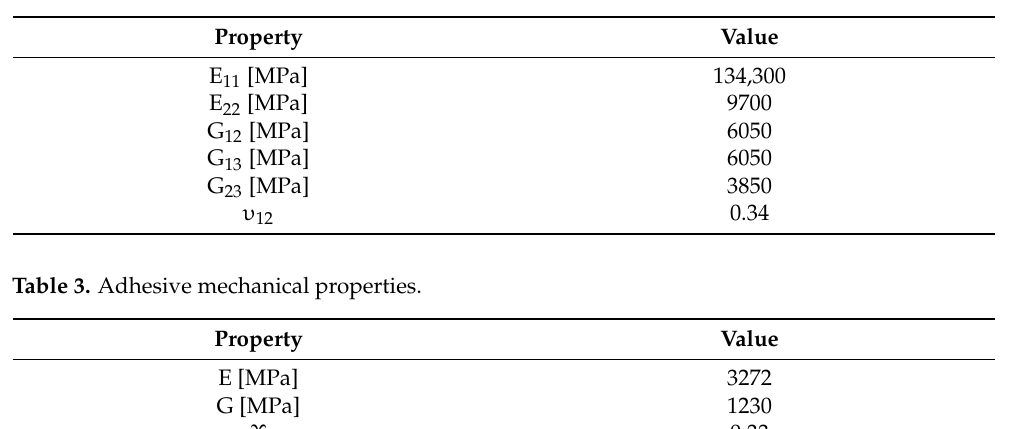
Table 2. Composite mechanical properties (single lamina).